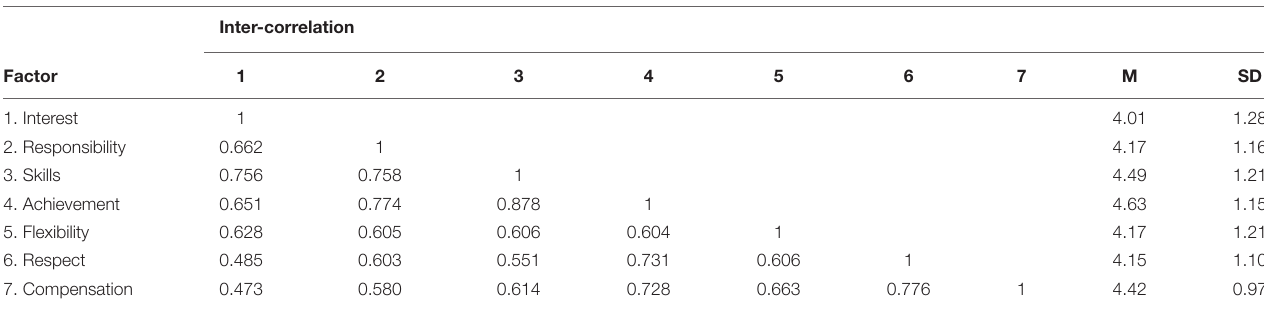
TABLE 11 | Inter-correlation of the seven-factor research